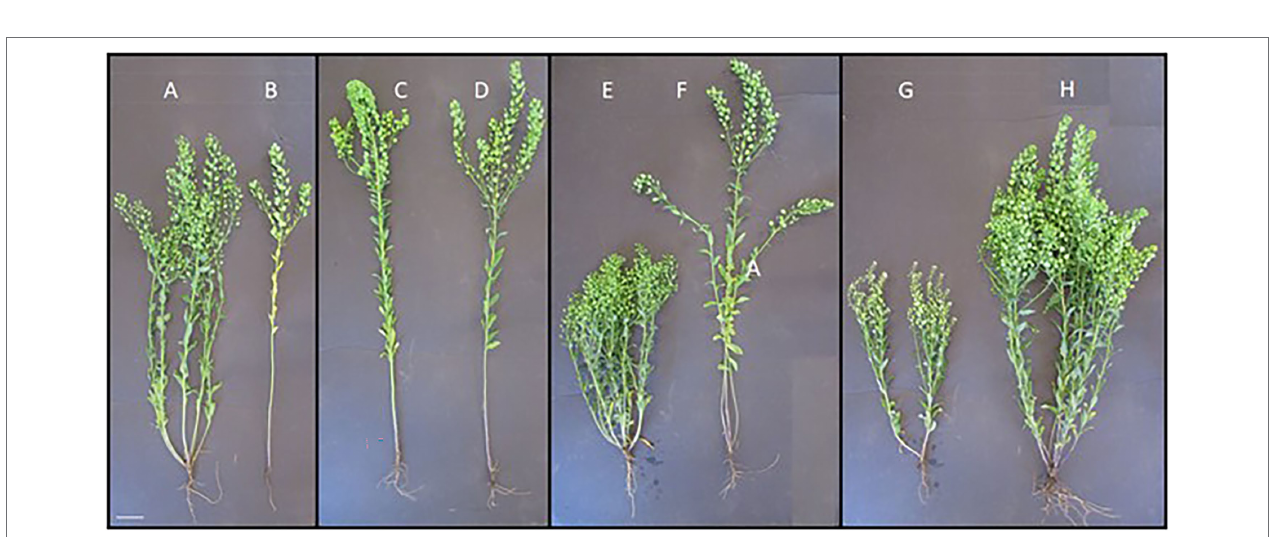
FIGURE 6 | Intercropping interaction window for winter oilseed intercropping systems. The orange curve represents biomass production and key growth stages in winter oilseed crop production and the green curve represents biomass production and key growth stages in soybean production.